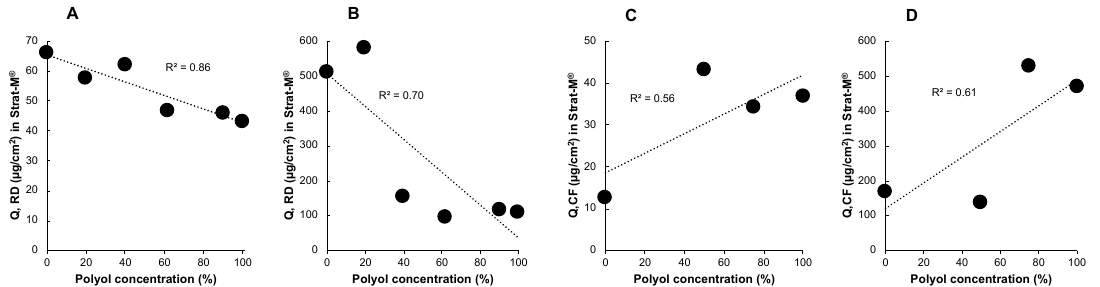
Figure 5. Relationship between permeation through Strat-M ® and polyol concentration in RD and CF formulations. Finite dose experiment with RD ( A ), infinite dose experiment with RD ( B ), finite dose experiment with CF ( C ), and infinite dose experiment with CF ( D ).